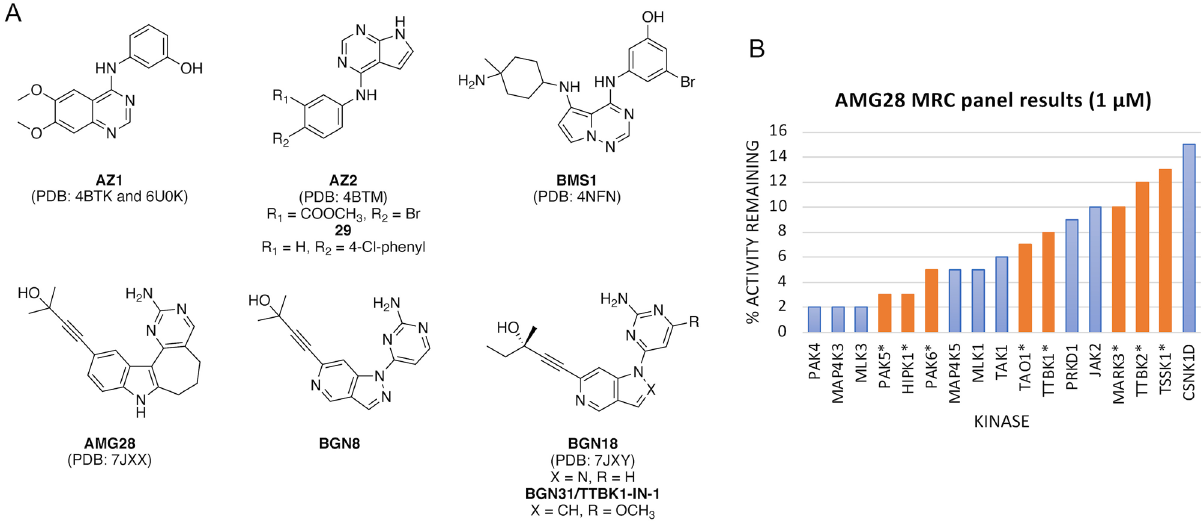
Figure 1. Structures and data for published TTBK inhibitors. ( A ) Structures of published TTBK1/2 inhibitors and PDB codes for corresponding structures. ( B ) AMG28 MRC panel screening results for kinases with < 15% activity remaining. IDG kinases indicated using asterisks and orange